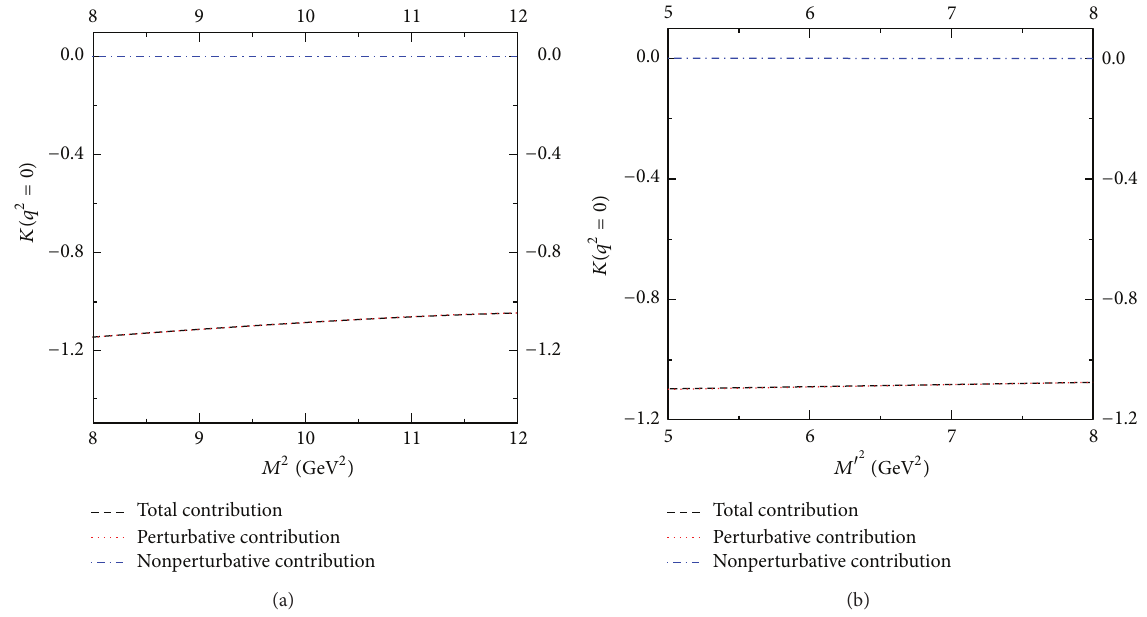
Figure 1: (a) 𝐾(𝑞 2 = 0) as a function of the Borel mass parameter 𝑀 2 at 𝑀 󸀠2 = 6.5 GeV 2 . (b) 𝐾(𝑞 2 = 0) as a function of the Borel mass parameter 𝑀 󸀠2 at 𝑀 2 = 10 GeV 2